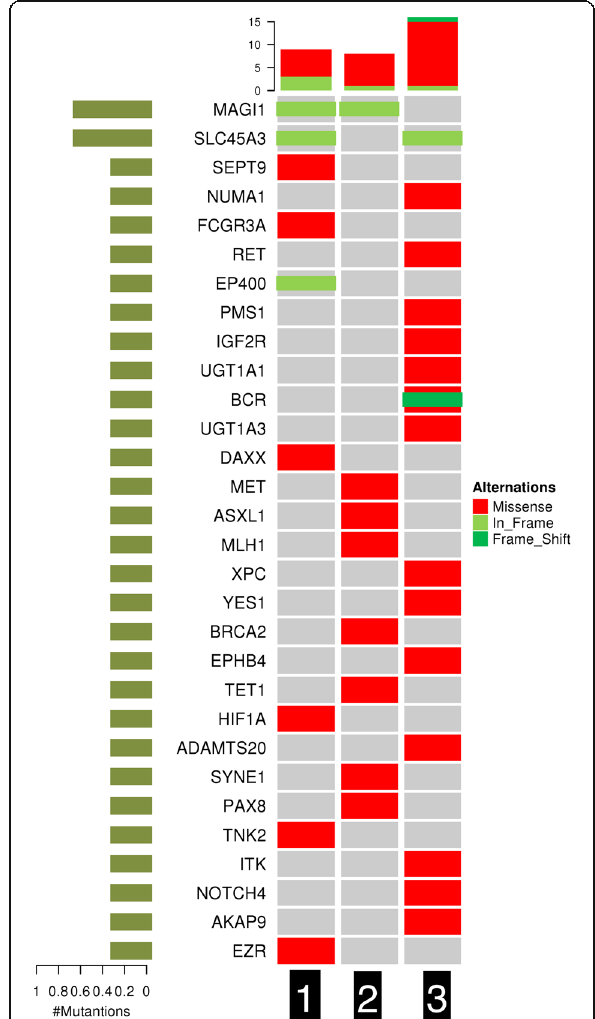
Fig. 2 The non-frameshift insertion of MAGI1 was observed in cases 1 and 2, and the non-frameshift insertion of SLC45A3 was showed in cases 1 and 3. The missense mutation was detected, and so was the non-frameshift deletion and the frameshift insertion in the